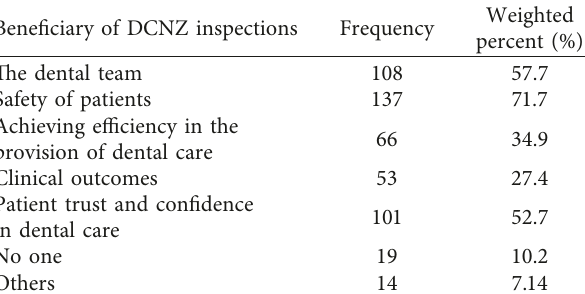
Table 8: Perceived benefits of DCNZ